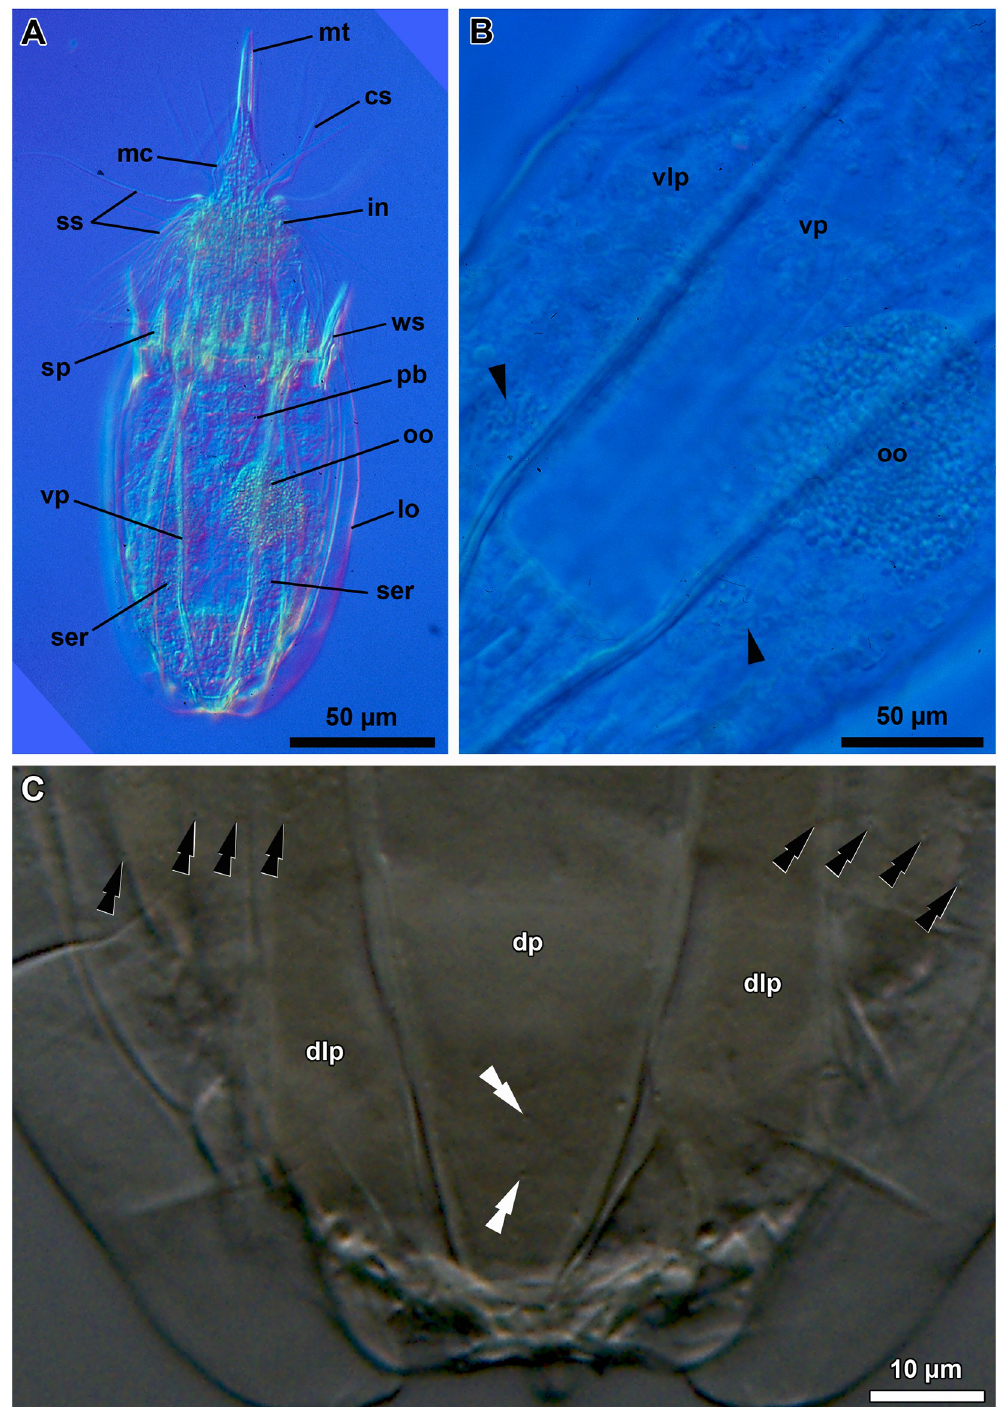
Fig 17. Light micrographs of a paratypic adult female of Scutiloricus hugoi gen. et sp. nov. (A) Overview of the fully extended specimen, anterior faces up. Note the presence of a large oocyte (oo) and two seminal receptacles (ser). (B) Close up of the oocyte and the two seminal receptacles (arrowheads). (C) Close up of the posterior region of the lorica. Note the linear arrangement of the four flosculi (black double arrowheads) on each dorsolateral plate (dlp) and the two flosculi (white double arrowheads) located medially on the dorsal plate (dp). Abbreviations: cs, clavoscalids; in, introvert; lo, lorica; mc, mouth cone; mt, mouth tube; sp, anterior spike; ss, spinoscalid; vlp, ventrolateral plate; vp, ventral plate; ws, wave-shaped lateral